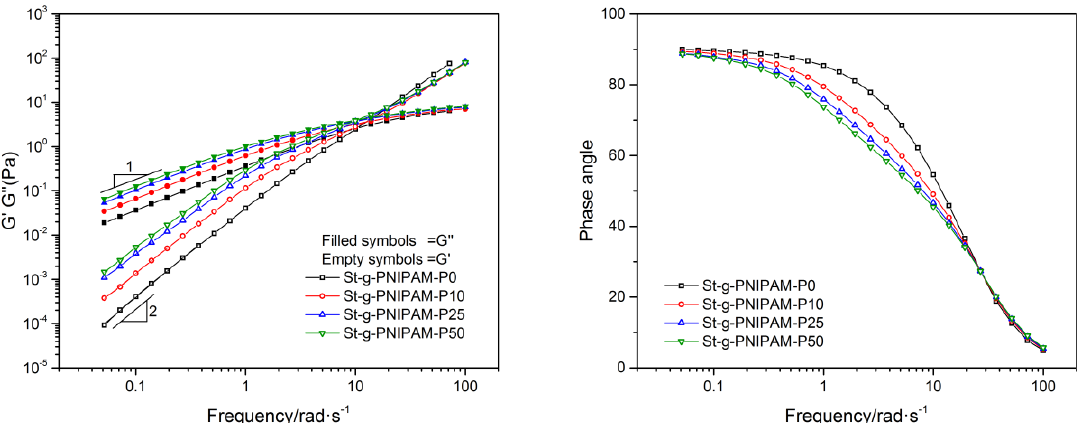
Figure 4. The storage (G′), loss storage (G′′) ( Left ) and phase angle ( Right ) as a function of frequency at 1.2 wt % copolymer concentration.